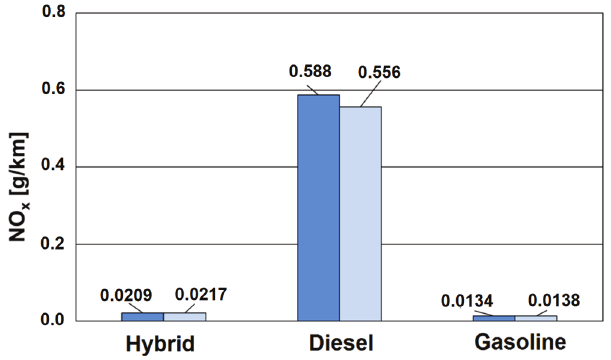
Fig. 16. Road NO x emission for each of the vehicles in the whole RDE test (EMROAD and all data)